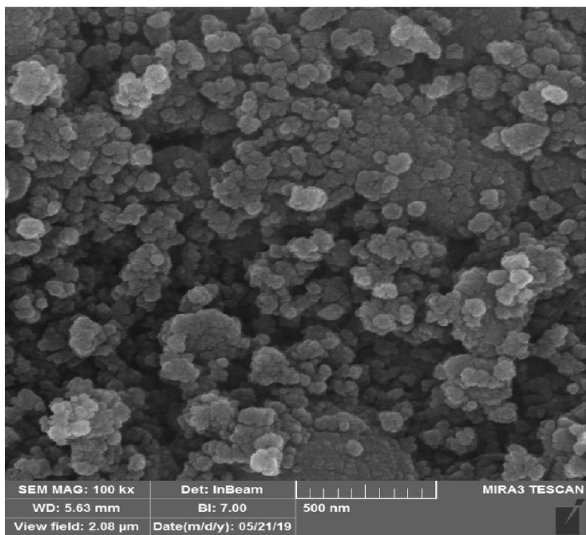
Figure 6. SEM image of Fe 3 O 4 @SiO 2 -Im[Br]-SB-Cu (II) nano-catalyst.